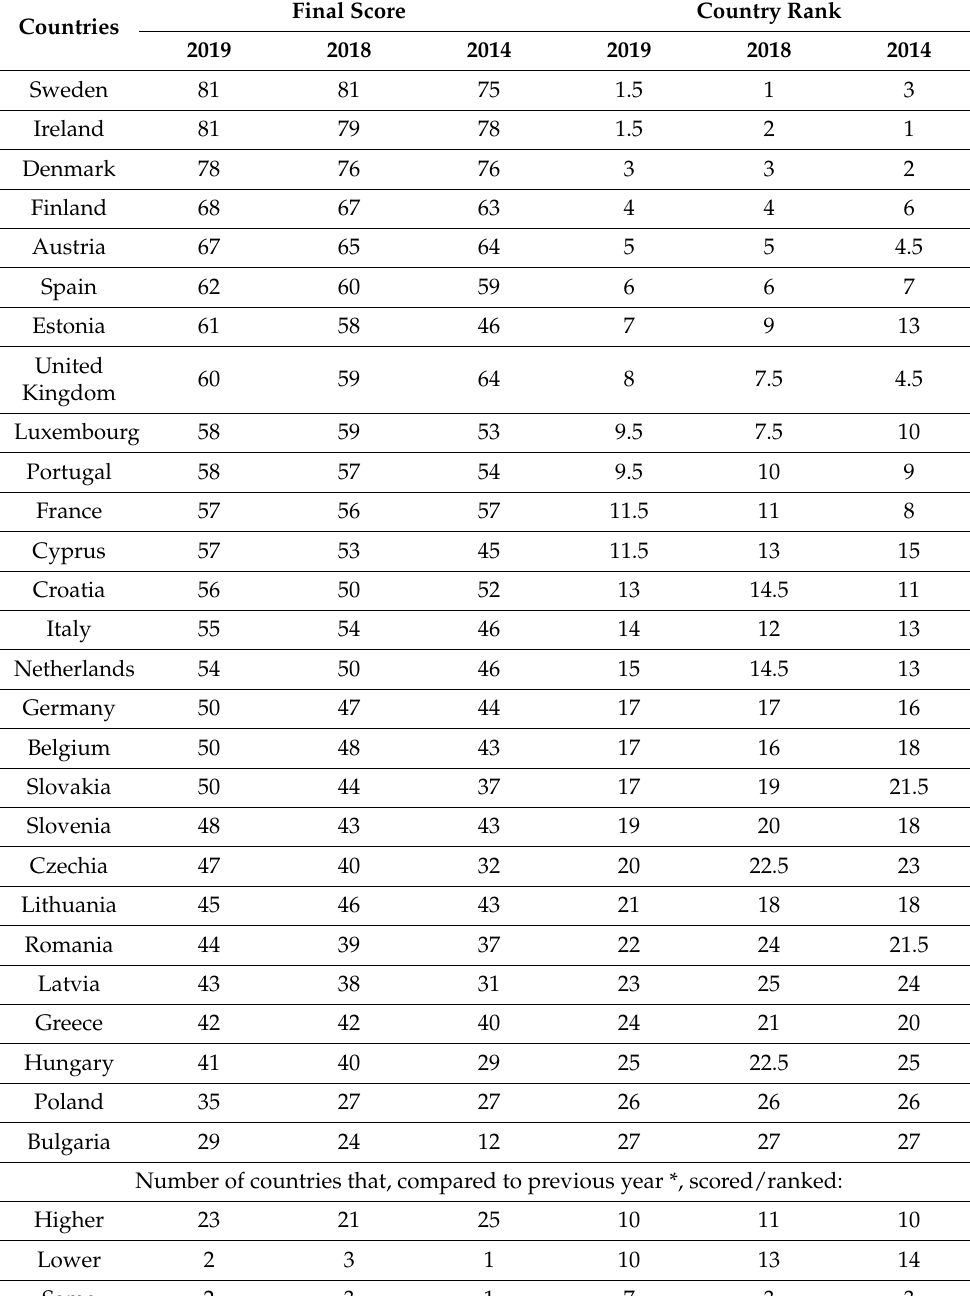
Table 9. Final scores and resulting country rankings, sorted by 2019 values.